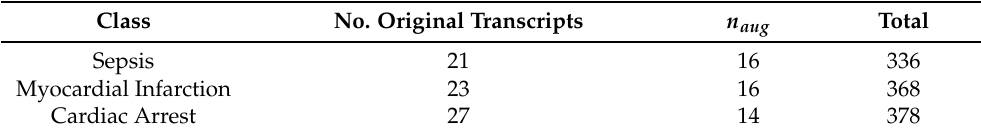
Table 2. Number of original training samples per diagnosis and the corresponding augmentation factor n aug .